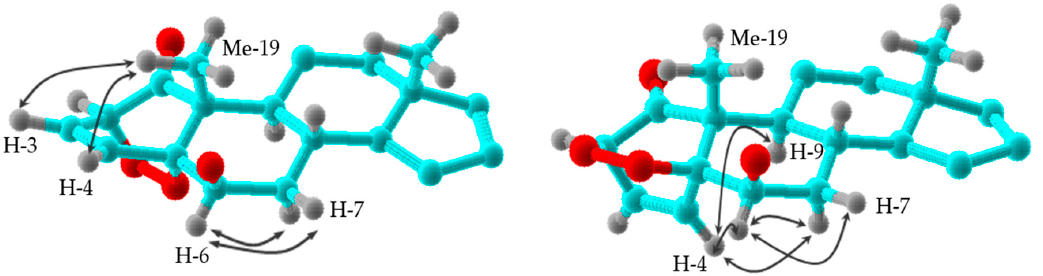
Figure 3. Selected 1 H- 1 H ROESY correlations of withaperoxidins A ( 1 ) and B ( 2 ). Withaperoxidin B ( 2 ) was assigned an identical molecular formula (C 28 H 38 O 8 ) to that of 1 by HRESIMS. A study of IR, UV, 1 H, and 13 C-NMR (Tables 1 and 2) and 2D spectra showed it to be a withanolide-type steroid with a carbonyl group ( δ C 205.9, C-1), a disubstituted endocyclic double bond [ δ H 6.67 (dd, J = 6.4, 8.1 Hz, H-3) and 6.58 (d, J = 8.1 Hz, H-4); δ C 125.9 (C-3) and 142.5 (C-4)], a primary hydroxyl group [ δ H 4.37, 4.41 (d AB , J = 11.8 Hz, H-27), and δ C 57.5 (C-27)], three oxymethine